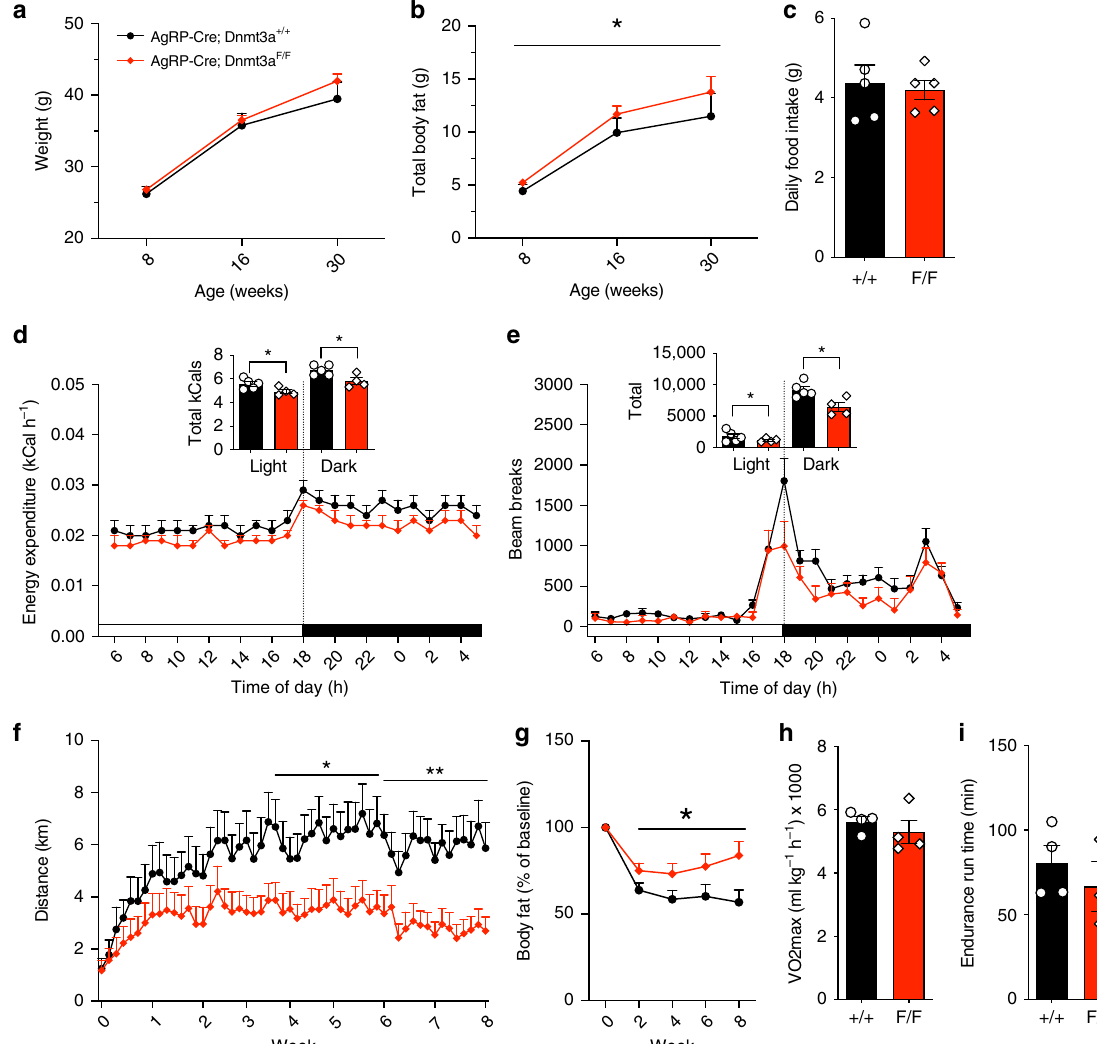
Fig. 2 Sedentary phenotype in F/F mice. a Male F/F mice show no difference in body weight relative to + / + mice, F (1, 32) = 3.56 Time×Genotype, p = 0.068, n = 6 – 12. b Male F/F mice show increased adiposity F (1, 33) = 4.75 main effect of Genotype, p = 0.036, n = 6 – 13. c Male F/F mice show no difference in daily food intake, whether adjusted or unadjusted (not shown) for lean and fat body mass, F (1, 6) = 0.003 main effect of Genotype, p = 0.955, n = 5. d Reduced energy expenditure in F/F mice. Inset: total caloric expenditure in light and dark periods, F (1, 15) = 7.649 Genotype×Sex interaction, p = 0.014, post-hoc comparison in male mice p = 0.042, n = 4 – 5. e Reduced locomotor activity in F/F mice. Inset: total locomotion in light and dark periods, F (1, 7) = 8.359, p = 0.023 main effect of Genotype, n = 4 – 5. f When given free access to a running wheel, F/F mice ran about half as much as + / + mice (data represent animals from two independent experiments, F (3, 72) = 7.258 Time×Genotype, p = 0.009). g When given access to running wheels, F/F mice lose less body fat than + / + mice, F (4, 96) = 3.60, p = 0.009 Genotype×Time, F (1, 24) = 4.77, p = 0.0039 main effect of Genotype, n = 13. h and i Metabolic treadmill testing shows that VO 2 Max ( h ), t (6) = 0.83, p = 0.436, and endurance run time at 60% of VO 2 Max ( i ), t (5) = 0.781, p = 0.47, do not differ between F/F and + / + mice, n = 3 – 4. Values re fl ect mean±SEM. *** p <0.001, ** p <0.01, * p <0.05. Source data for a – i are provided as a Source Data fi